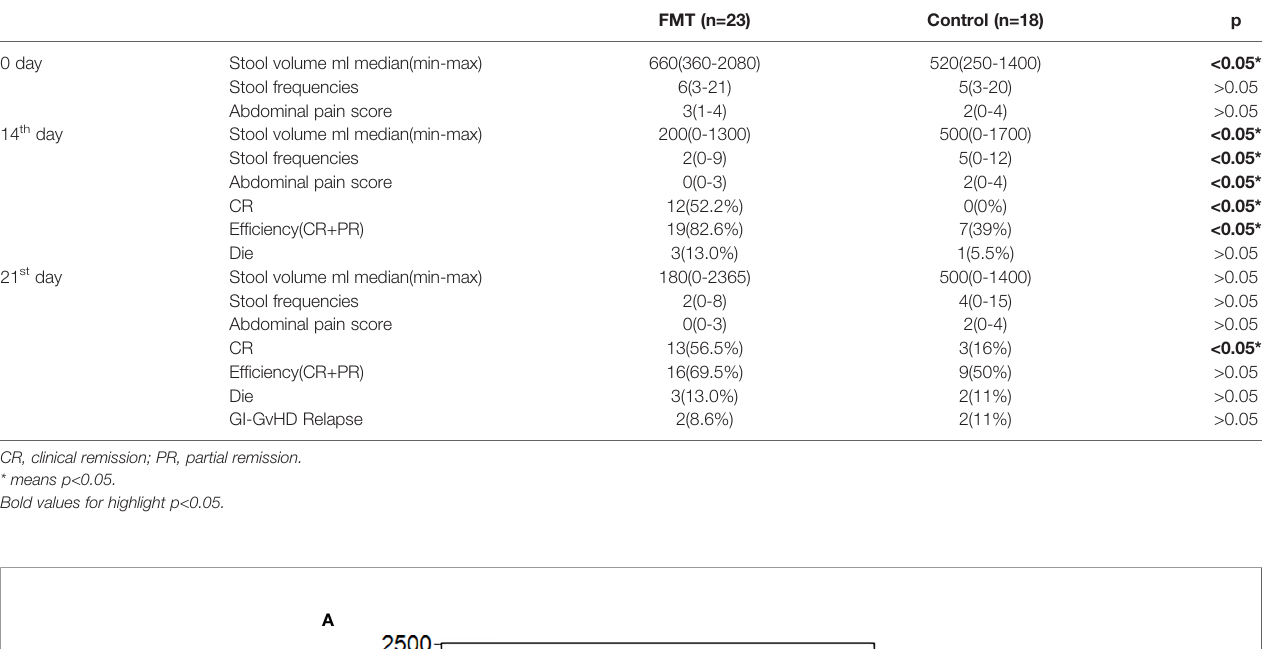
TABLE 2 | Clinical results of 14 th day and 21 st